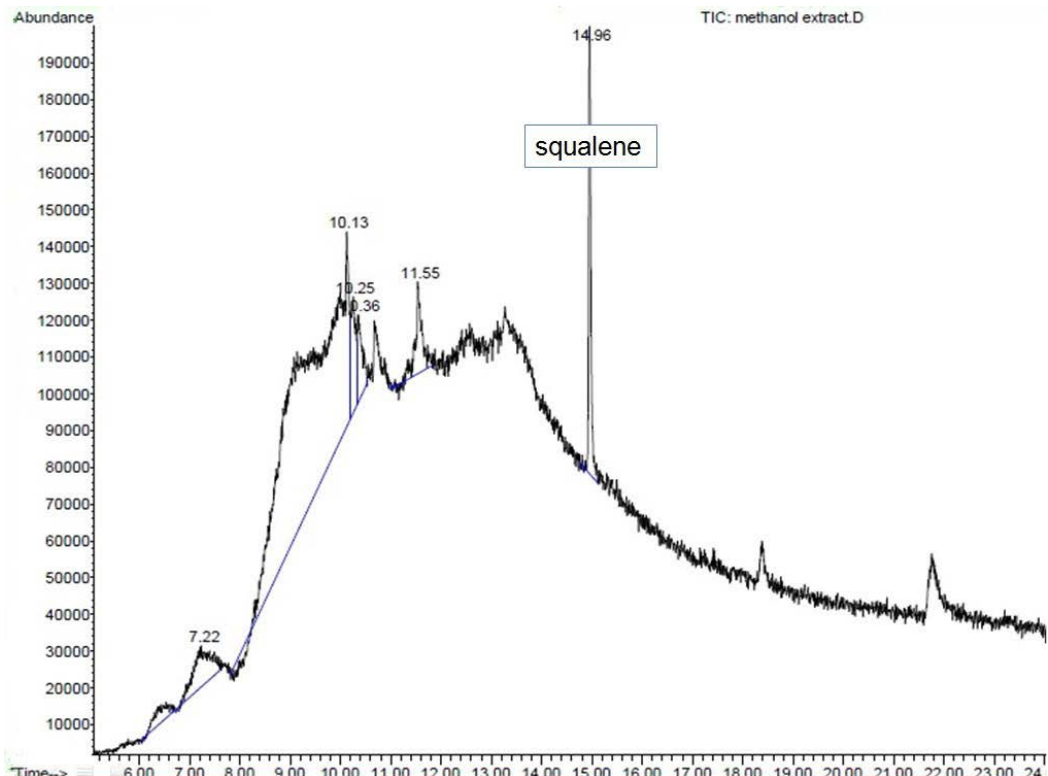
Figure 9. Gas Chromatography–Mass Spectrometry (GC-MS) chromatogram of methanol extract (ME) of S. polyanthum leaf with squalene as